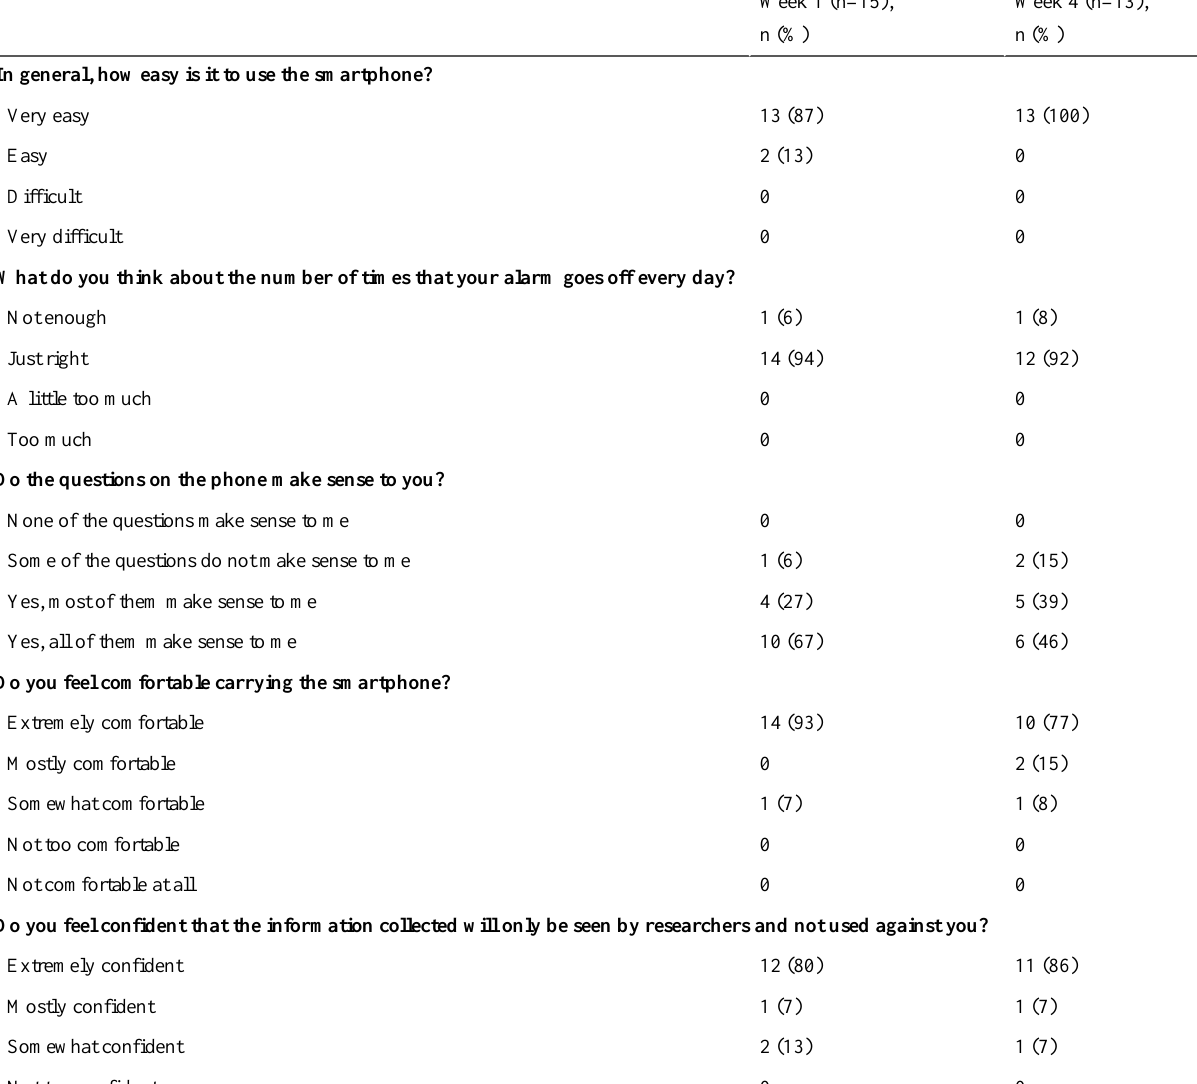
Table 5. Acceptability